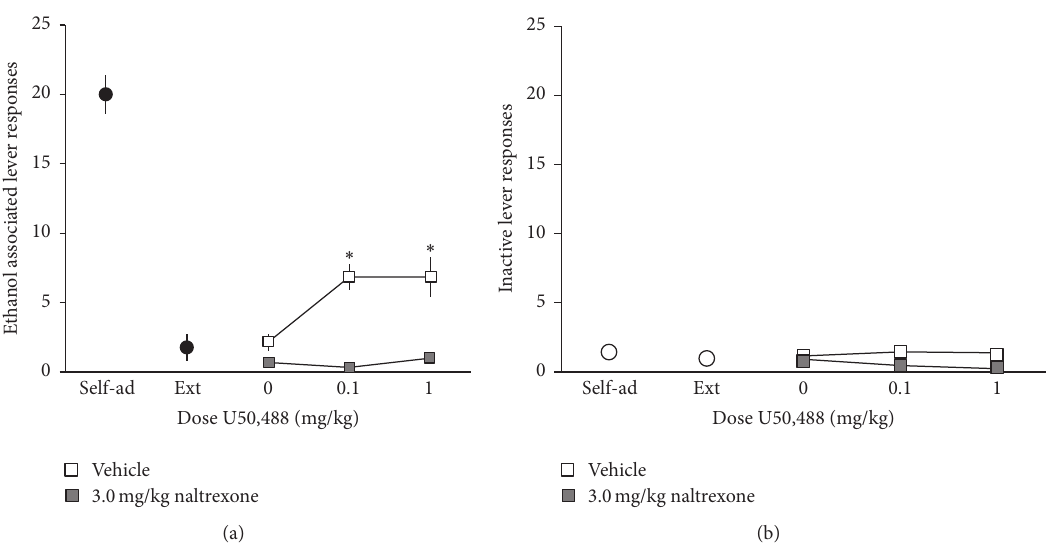
Figure 4: (a) Naltrexone blocks U50,488-induced reinstatement of ethanol seeking. Rats ( 𝑛 = 13 ) were trained to self-administer a 10% ethanol solution using standard operant procedures, and then lever pressing for ethanol was subsequently extinguished. Following extinction, rats were pretreated with naltrexone (0 or 3.0 mg/kg, s.c.) 30 min prior to reinstatement testing. Prior to testing, rats received priming injections of U50,488 (0–1.0mg/kg, i.p.) and were tested for reinstatement of responding on the previously ethanol-associated lever. Tests were conducted every 3-4 days, with rats experiencing extinction sessions daily between test days. Data are expressed as the mean number of lever responses ± SEM during ethanol self-administration sessions. ∗ 𝑝 < 0.05 compared to saline-injected rats receiving the same dose of U50,488, Sidak’s test for multiple comparisons. (b) Responding on an inactive lever was measured as an indication of general motor activity. No effects on inactive lever responding were observed.